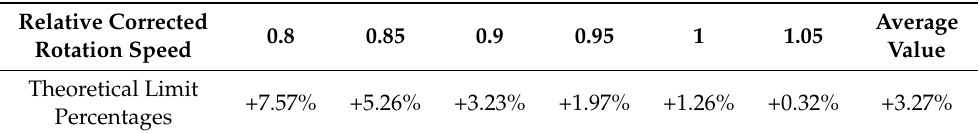
Table 3. The Theoretical Limit Percentages of Flow Rate Adjustment with Certain Front Fan Surge Margin ( ∆ SM FF > 10%).